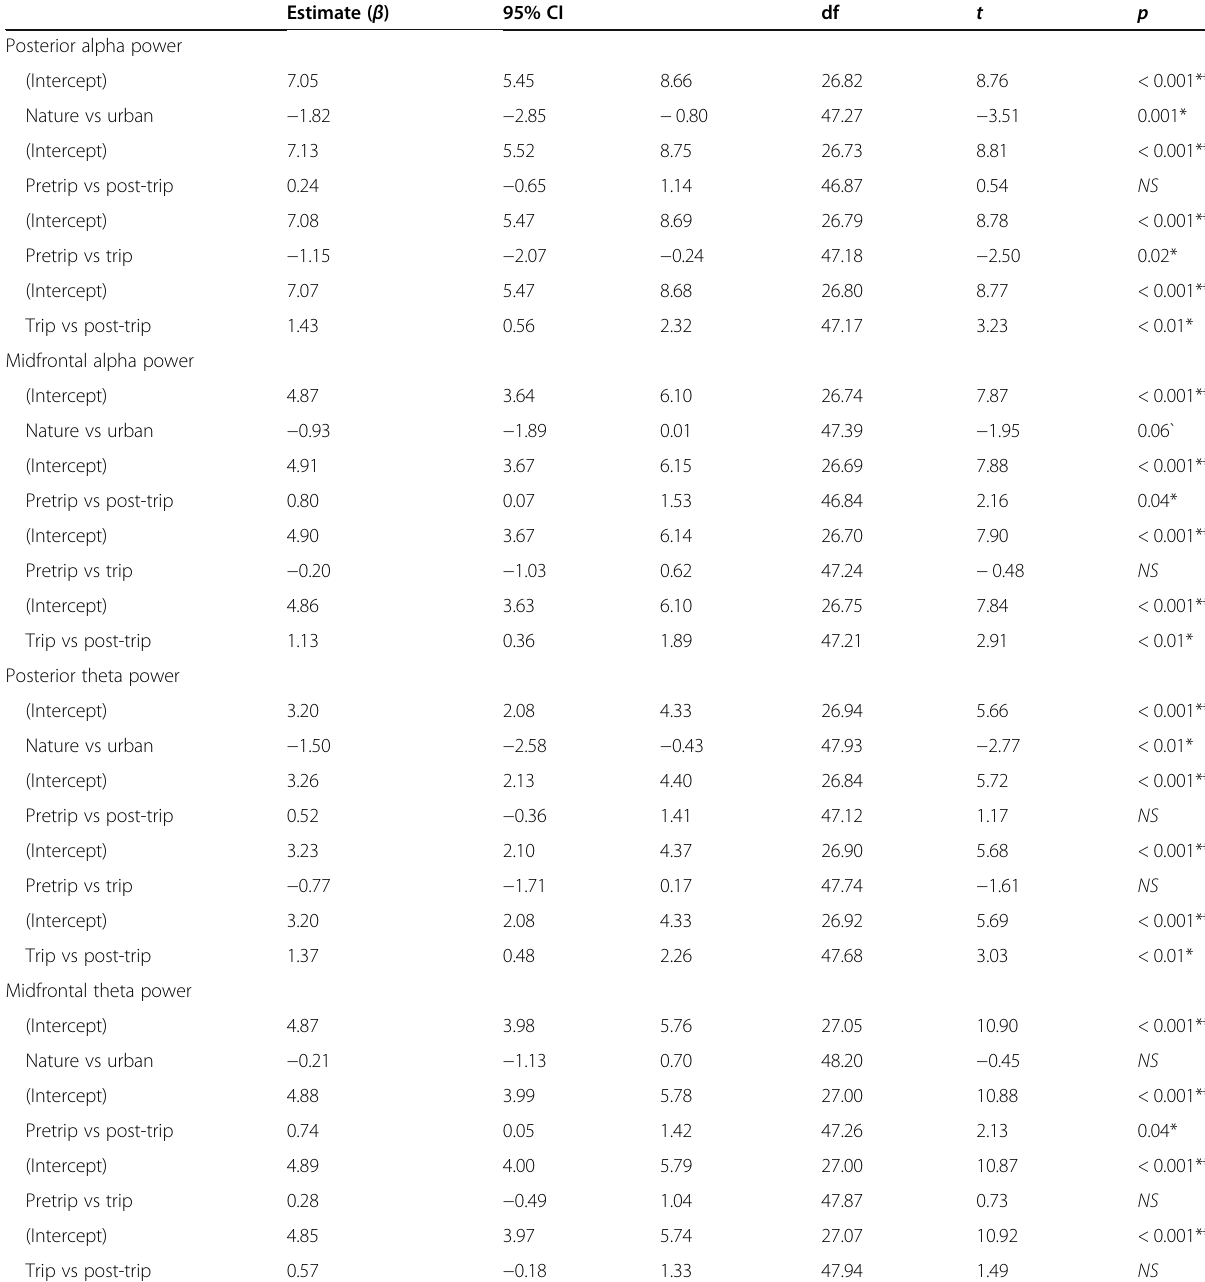
Table 3 Regression coefficients for session comparisons regressed onto electrode sites for power collected during eyes-closed rest Estimate ( β ) 95% CI